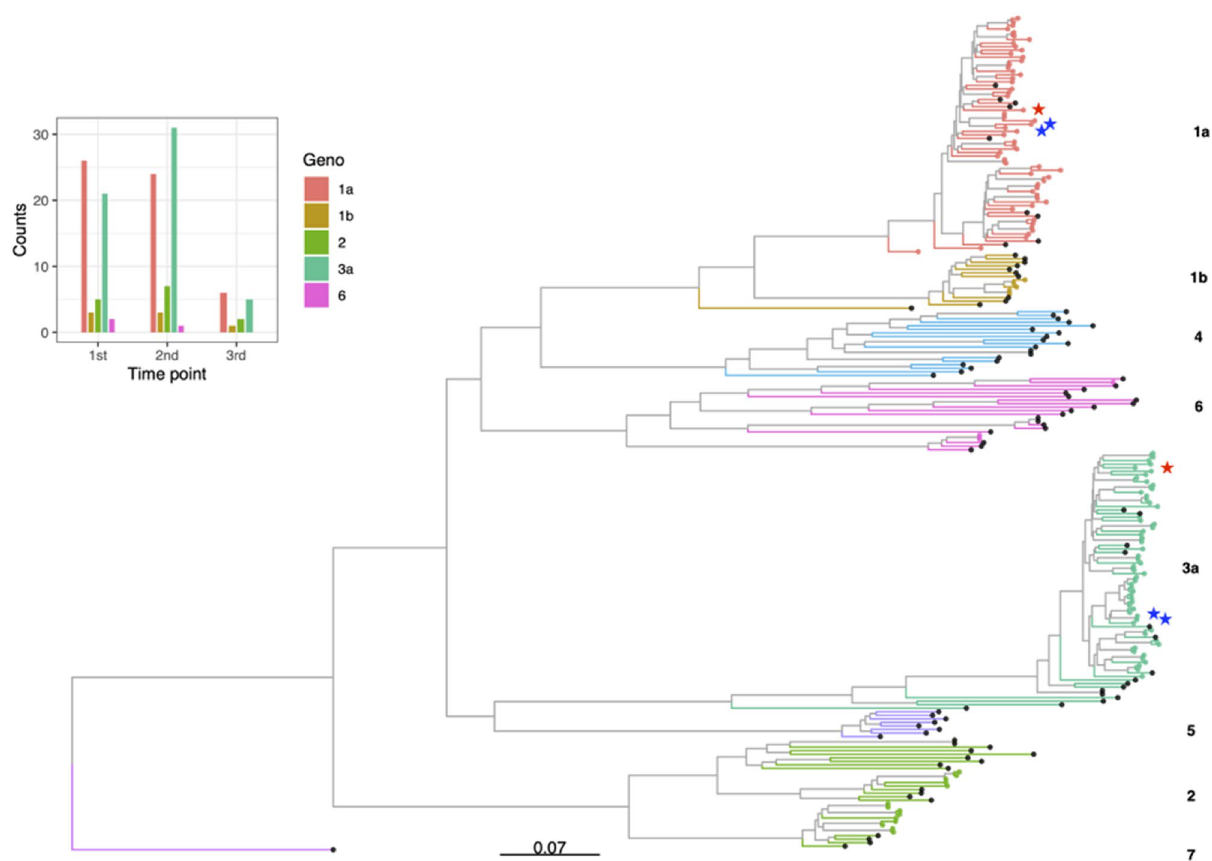
Figure 1. Phylogenetic tree of HCV consensus sequences and genotype counts. Maximum likelihood phylogenetic tree of HCV WGS. Reference genomes for each genotype are shown with black points and different coloured tips signify those included in this study. This tree was rooted on a genotype 7 reference sequence. Stars indicate mixed infections which were removed from subsequent analyses, red for sample 33 and blue for sample 983 (two longitudinal samples). Inset bar chart depicts counts of genotypes for each sample (including mixed and genotype switches) separated by time